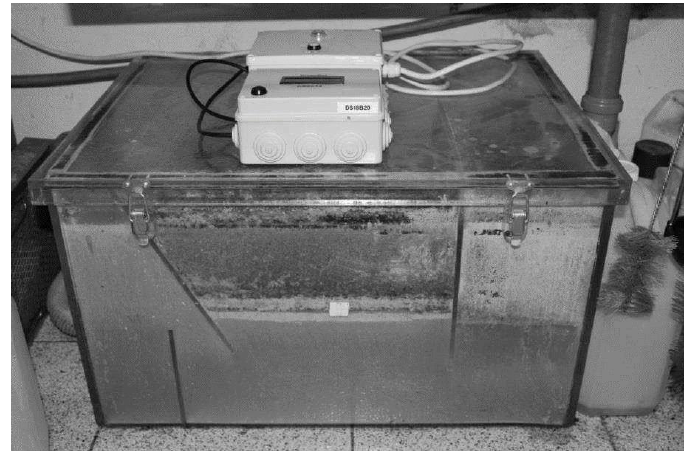
Figure 17. Transparent grease box for temperature monitoring.